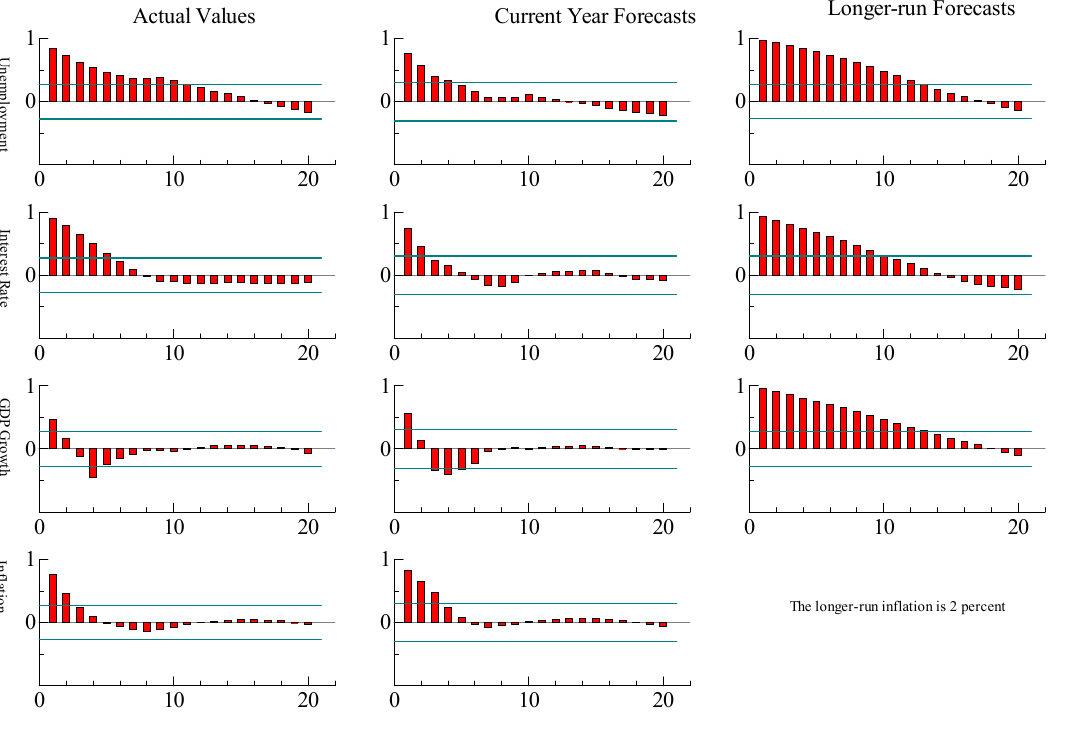
Figure A1. Autocorrelation coefficients for record data ( left column), current-year forecasts ( middle column), longer-run forecasts ( right column).